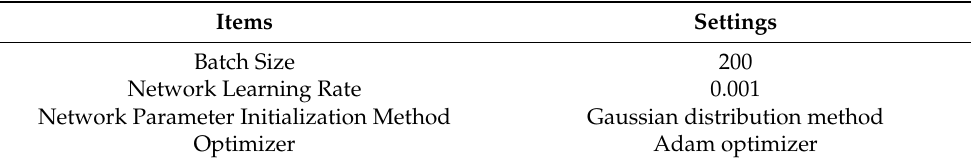
Table 2. The network training